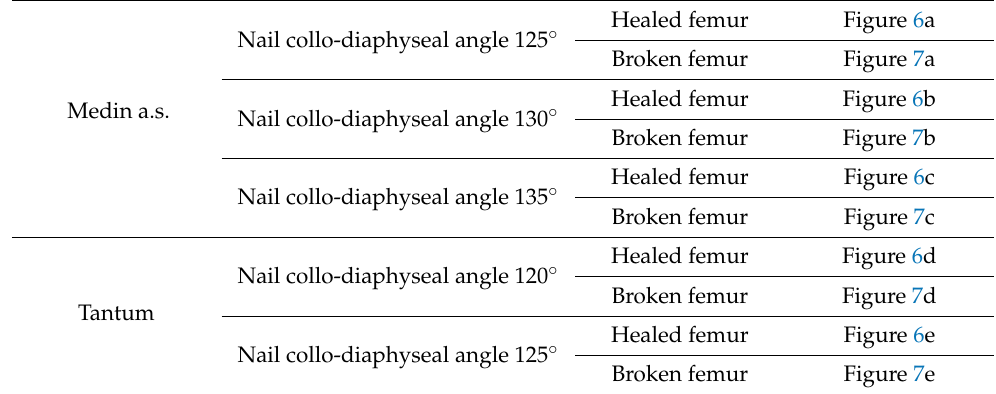
Medin a.s. Medin Medin a.s.